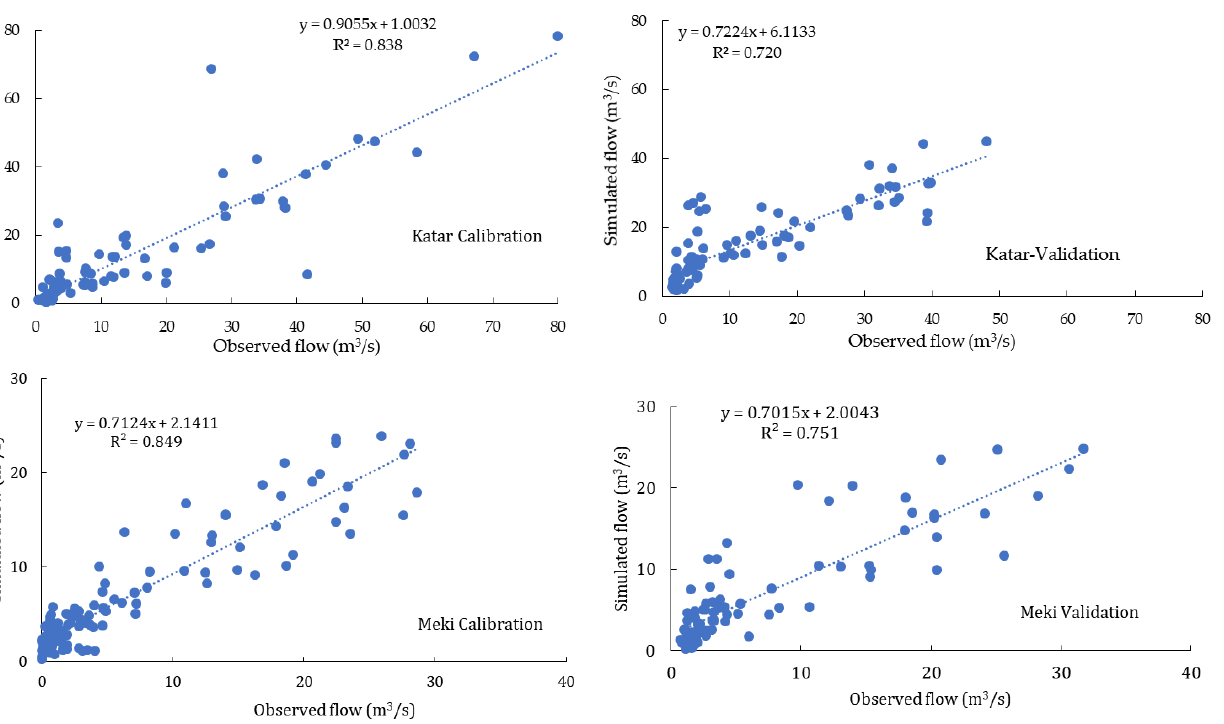
Figure 5. Stream flow calibration and validation result of Meki subbasin near Meki Village station (1999 – 2014).